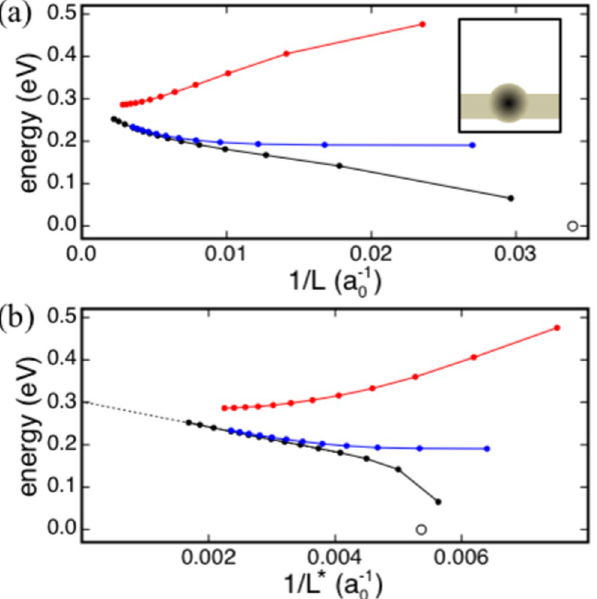
Figure 5. ( a ) Energy vs. L − 1 for a singly negatively charged S vacancy in monolayer MoS 2 calculated by using orthorhombic supercells with edges parallel to the monolayer equal to l x and = l l 3/2 , and with a y x perpendicular edge equal to (red) l z = 2 l x , (black) l z = l x , or (blue) l z = l x + d ( d = 6.1 Å is an approximate value for the monolayer thickness). Energy values are obtained with supercells of increasing l x and plotted against = L l l l = ⁎ L L  , with x y z . ( b ) Same as ( a ), with energy values plotted versus the rescaled linear dimension SC  is the component of the dielectric tensor parallel to the monolayer. Discs show , where   = − + d l ( 0 z 0 energy values obtained by using our energy scheme, and the dotted line shows the linear interpolation of energy values at large L obtained by using supercells with l z = l x . Energy values are referred to that one obtained with the same supercell used to calculate the defect formation energy by DFT. The inset shows a schematics of the defected 2D